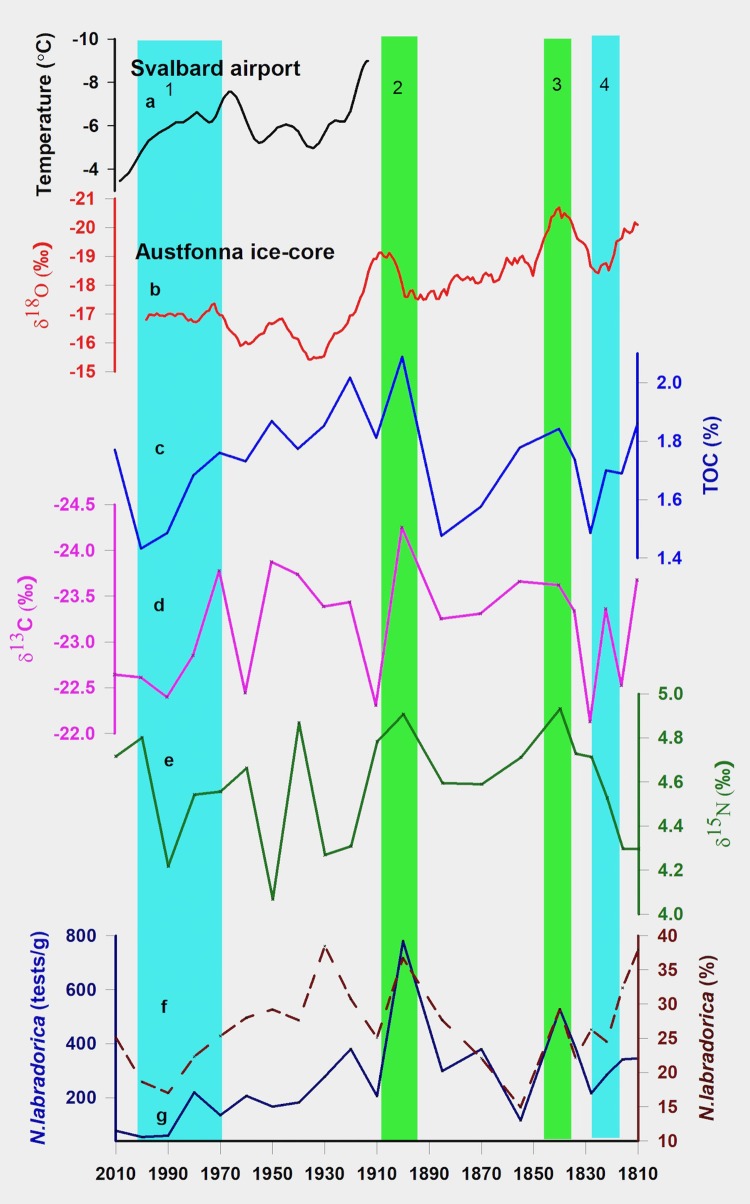
(a) Svalbard airport temperature record (b) δ18O of Austfonna ice-core record from Svalbard and down-core variability of (c) TOC, (d) δ13C, (e) δ15N, and (f,g) microfossil abundance of Nonionellena labradorica, in the present study.